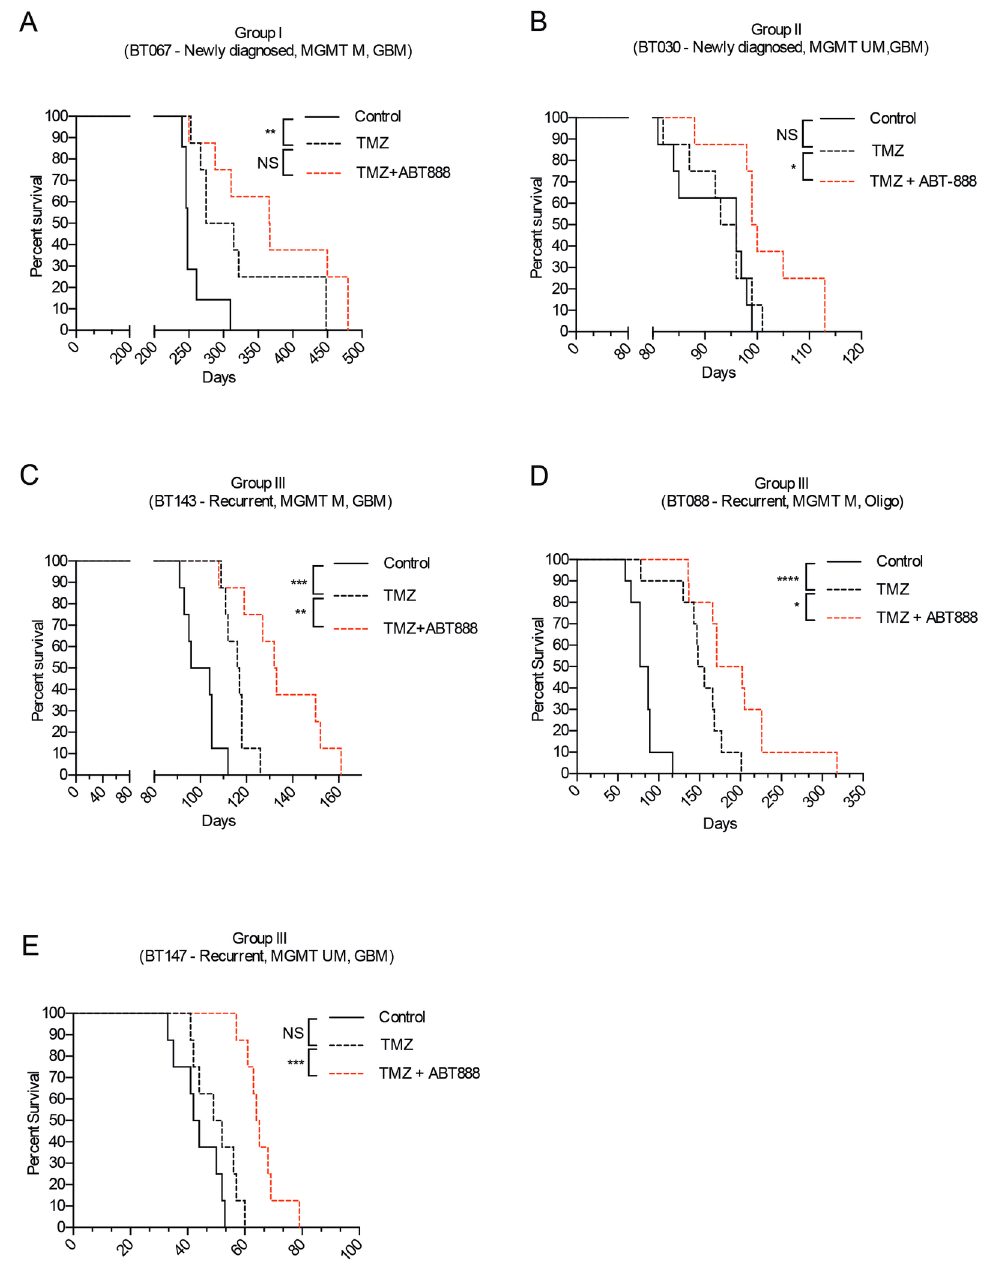
Fig 5. Kaplan-Meier survival curves of mice treated with DMSO, TMZ, or TMZ and ABT-888. Mice were implanted with BTICs from Groups I, II and III. Mice bearing BT067 (A), a Group I line, lived significantly longer after TMZ, but had no further survival benefit from the addition of ABT-888 to TMZ. Mice bearing BT030 (B), a Group II line, did not live longer after TMZ alone, but lived significantly longer after the addition of ABT-888 to TMZ. Mice bearing BT143 and BT088 (C, D), methylated lines from Group III, lived significantly longer after TMZ and longer still after the addition of ABT-888 to TMZ. Mice bearing the BT147 (E), a Group III unmethylated line, did not live significantly longer after TMZ, but had significantly longer survival after the addition of ABT-888 to TMZ. The log-rank (Mantel-Cox) test was used to compare survival curves (ns = p > 0.05; (cid:3) = p < 0.05; (cid:3)(cid:3) = p < 0.01; (cid:3)(cid:3)(cid:3) = p < 0.001; (cid:3)(cid:3)(cid:3)(cid:3) = p < 0.0001).